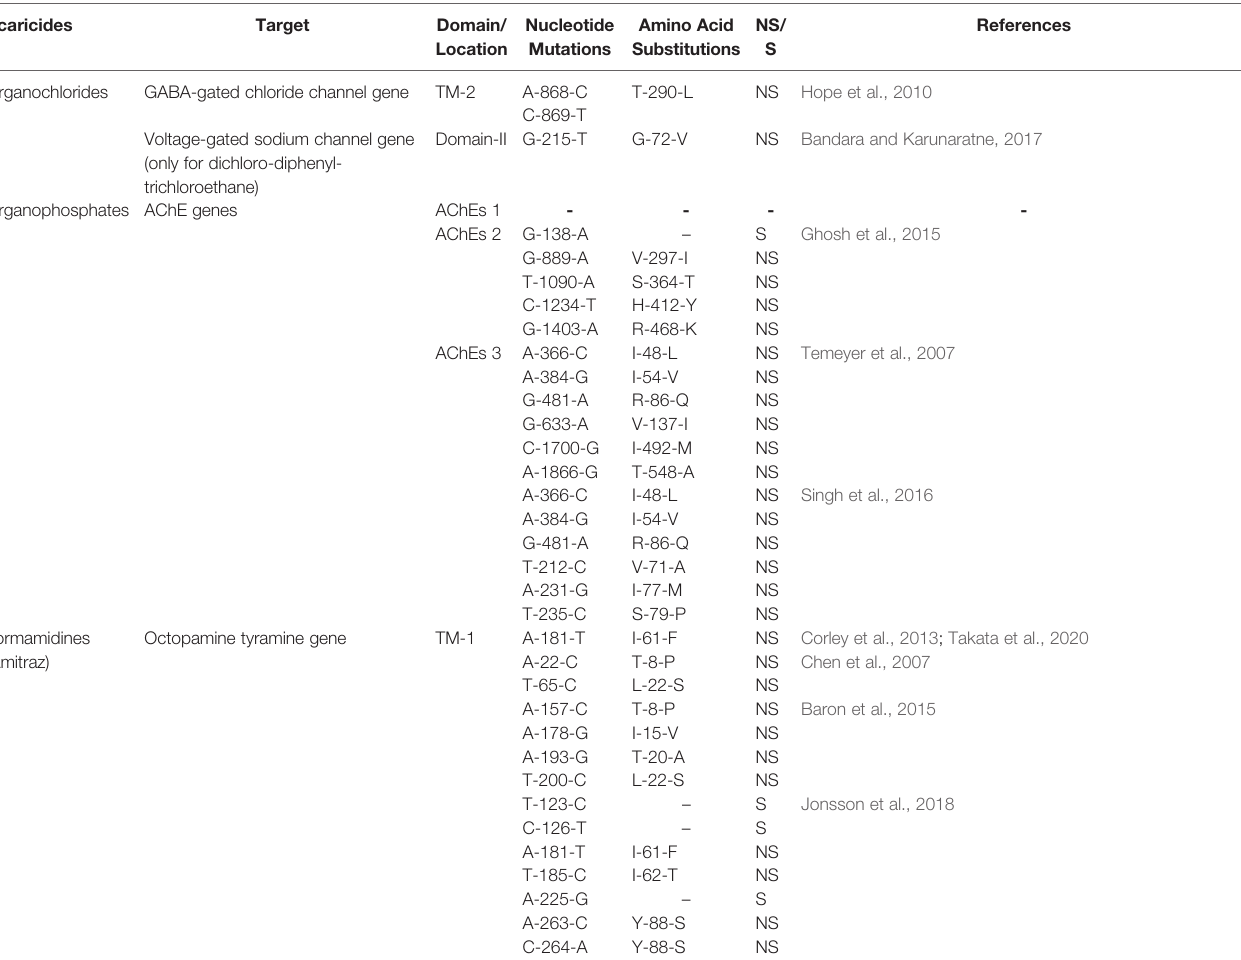
TABLE 2 | Nucleotide and amino acid substitutions in acaricide target genes in Rhipicephalus microplus ticks. Acaricides